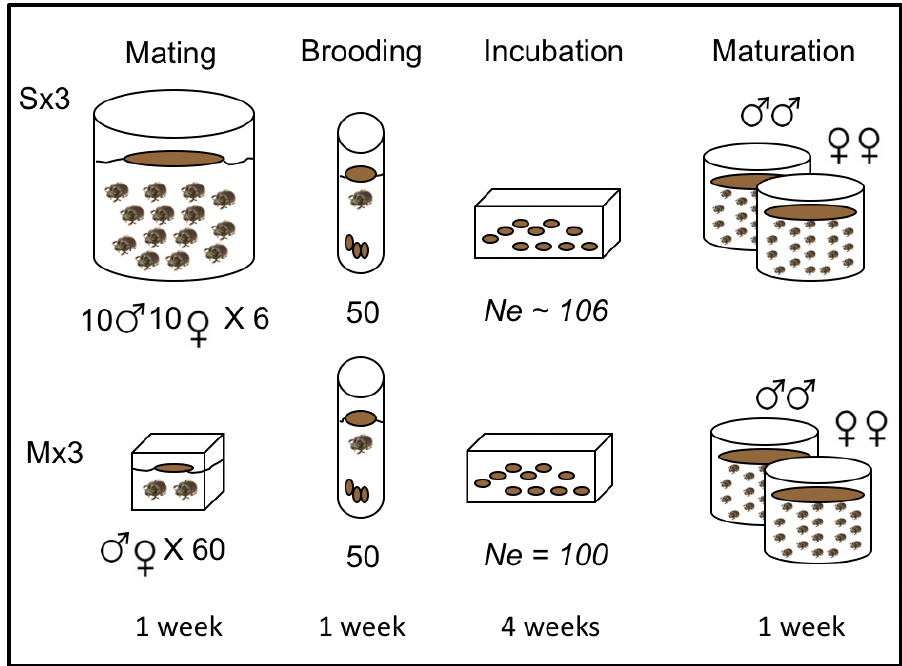
Figure 1. Experimental evolution protocol. S, sexual selection; M, enforced monogamy; Ne , effective population size.